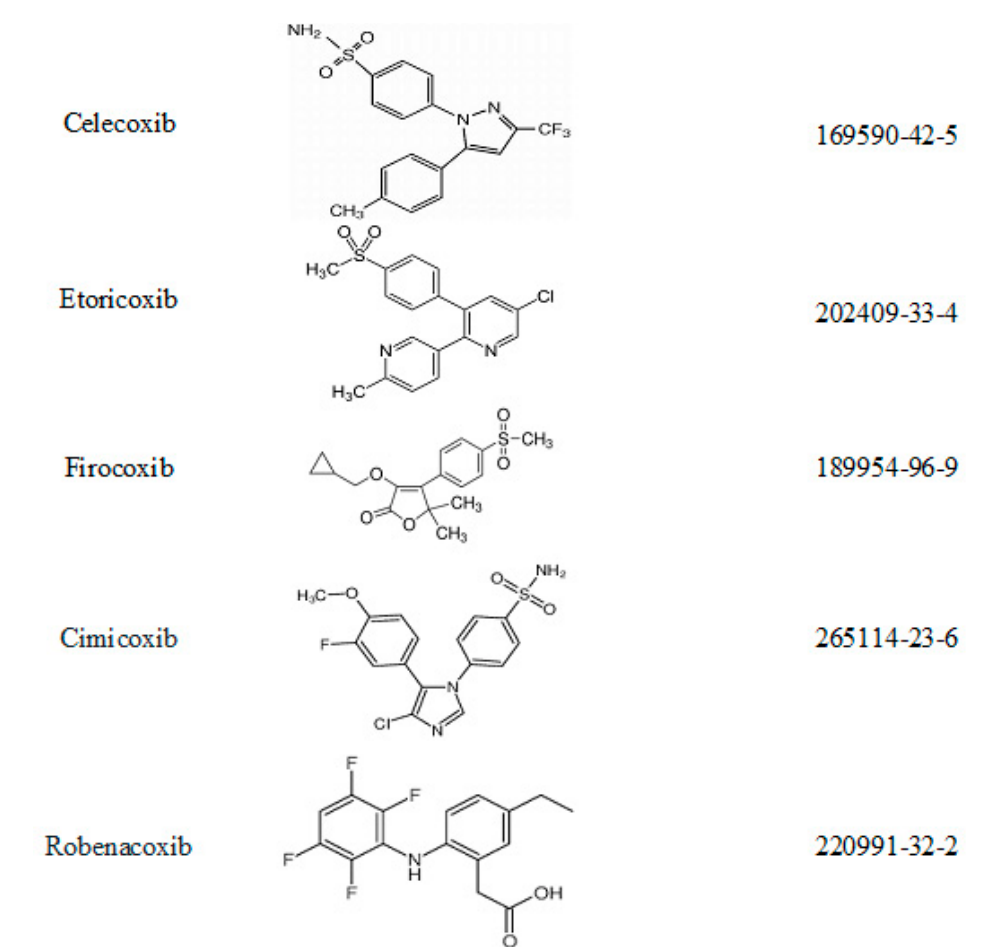
Figure 1. Chemical structure and CAS numbers of analyzed compounds.